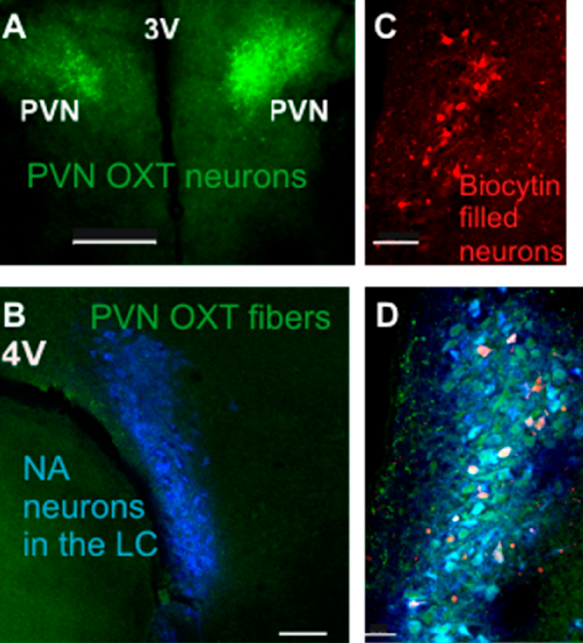
Figure 2. Selective expression of ChR2 in PVN OXT neurons and colocalization of ChR2 fibers surrounding D β H+ and biocytin filled NA neurons in the locus coeruleus. ( A ) Low power confocal image shows ChR2-EYFP (green) expression in the PVN. ( B ) PVN OXT ChR2 fibers (green) co- localize and surround LC noradrenergic neurons (NA) shown with dopamine β hydroxylase (D β H) immunohistochemistry (blue). ( C ) LC NA neurons recorded with patch clamp electrodes were filled with biocytin (red); ( D ) Merged image illustrates the co-localization of PVN OXT fibers (green) with D β H LC NA neurons (blue), and biocytin-filled patched LC NA neurons (red). Scale bar 400 µ m ( A ), 200 µ m ( B ), 100 µ m ( C ), and 50 µ m ( D ).